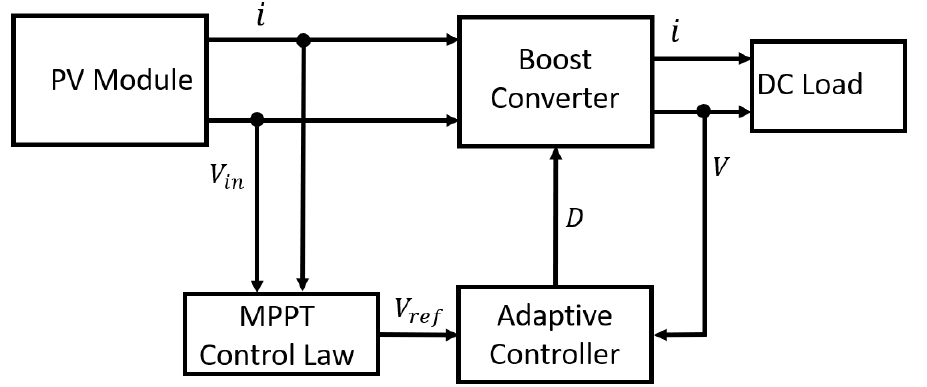
Figure 6. PV module with the maximum power point tracking (MPPT) adaptive controller.